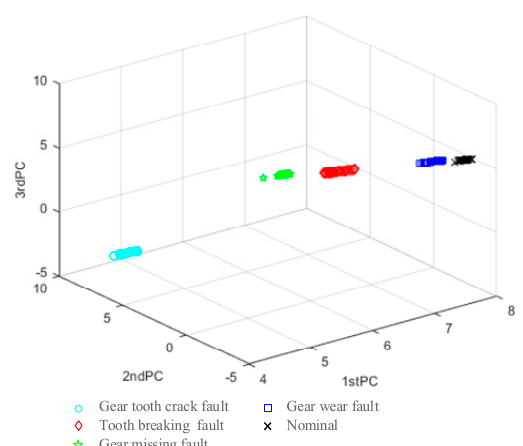
Figure 17. Clustering result of VMD-time-frequency information entropy under condition 3.